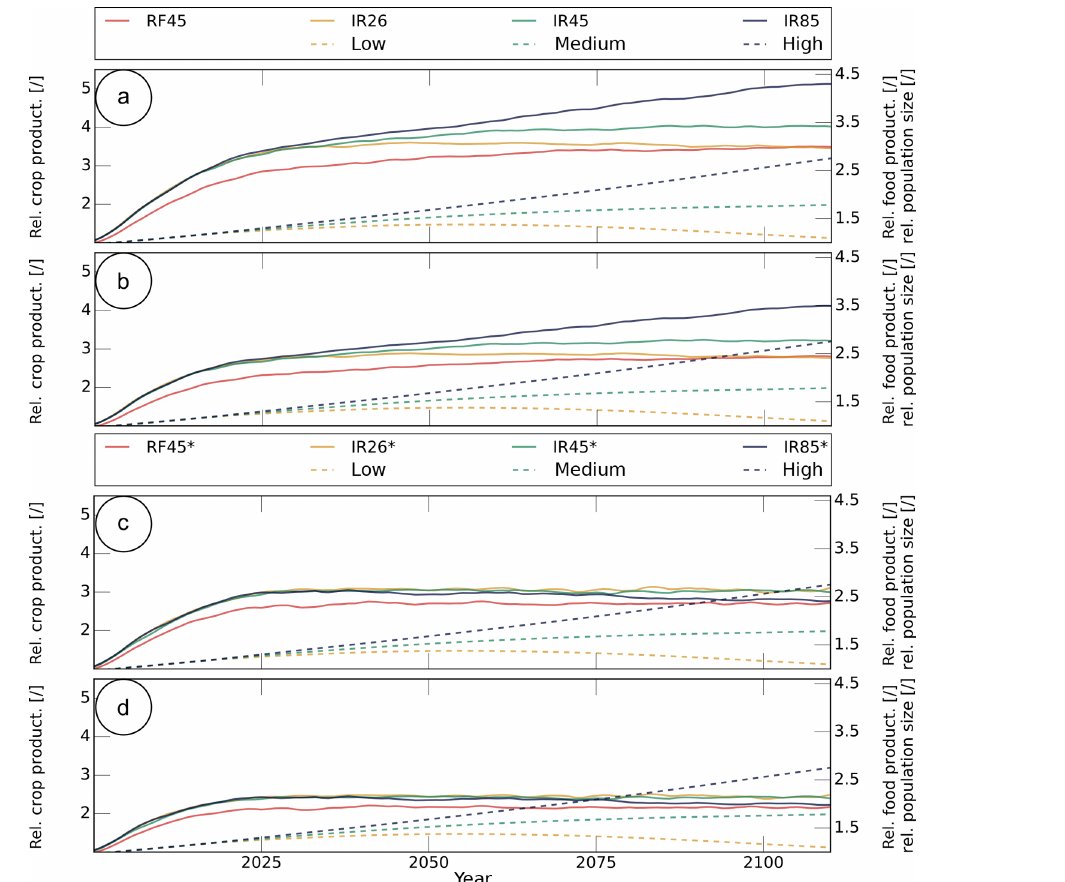
Figure 5. Global food supply and UN population development scenarios (10-year running mean). (a) Left axis: solid lines indicate the global aggregate production of croplands relative to present-day productivity (2000–2009 mean; REF). Right axis: solid lines indicate relative global food production. Dashed lines (right axis) indicate the population size of the UN fertility scenarios (UN, 2015a) relative to the global population in 2005. (b) Same as (a) but excluding protected areas. (c) Same as (a) but without the CFE. (d) Same as (b) but without the